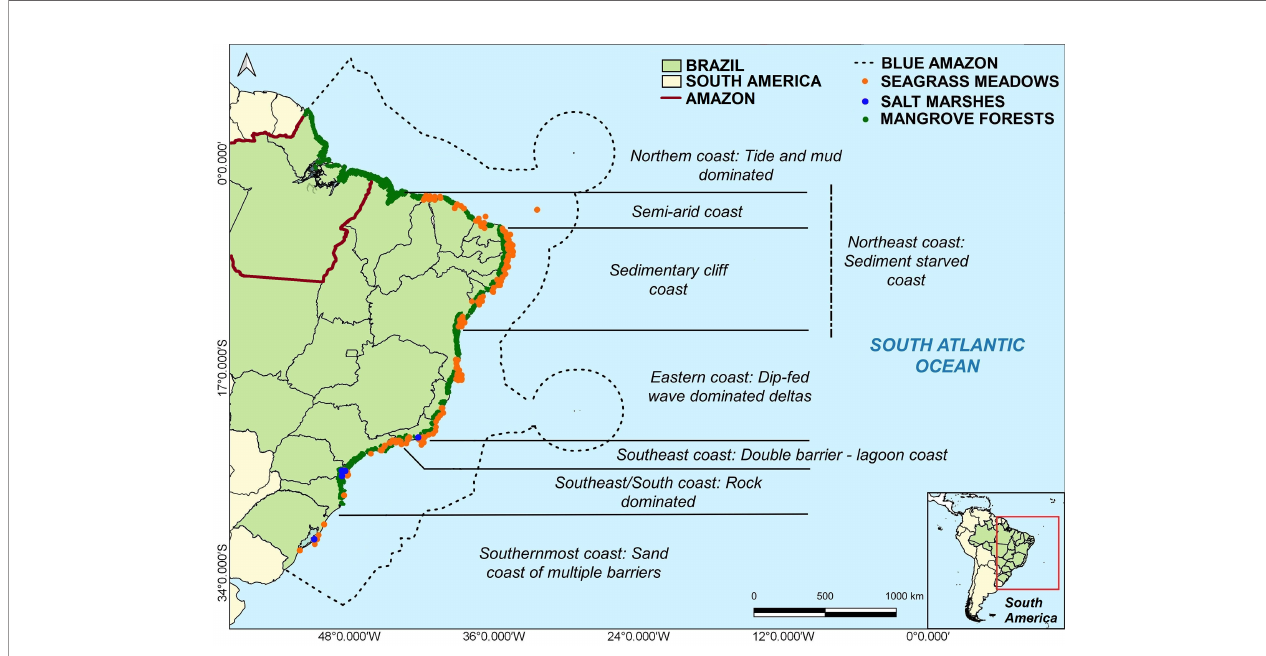
FIGURE 1 | Map showing the spatial distribution of major blue carbon ecosystems (BCEs) in the Brazilian coast. The dashed line presents the limits of the Blue Amazon (Brazilian Economic Exclusive Zone). The orange, blue, and green dots represent the seagrass meadows, salt marshes, and mangrove ecosystems, respectively. Sources: Wiesebron (2013); Copertino et al. (2016); Ferreira and Lacerda (2016); Schaeffer-Novelli et al. (2016), and Lacerda et al. (2019). Coastal geomorphological settlings according to Muehe